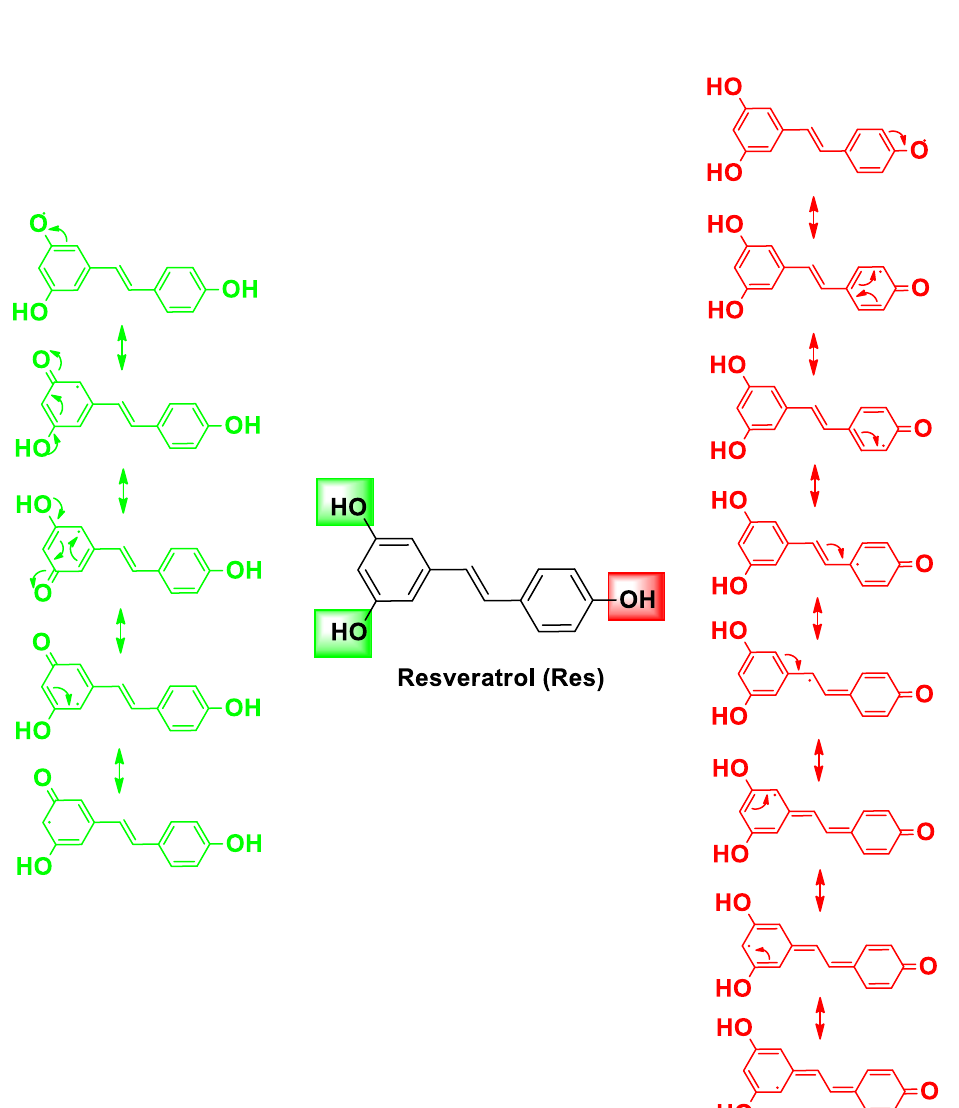
Figure 2. Resonance structures of the semiquinone form of Res after hydrogen abstraction of the catechol -OH (green) and phenol -OH (red).